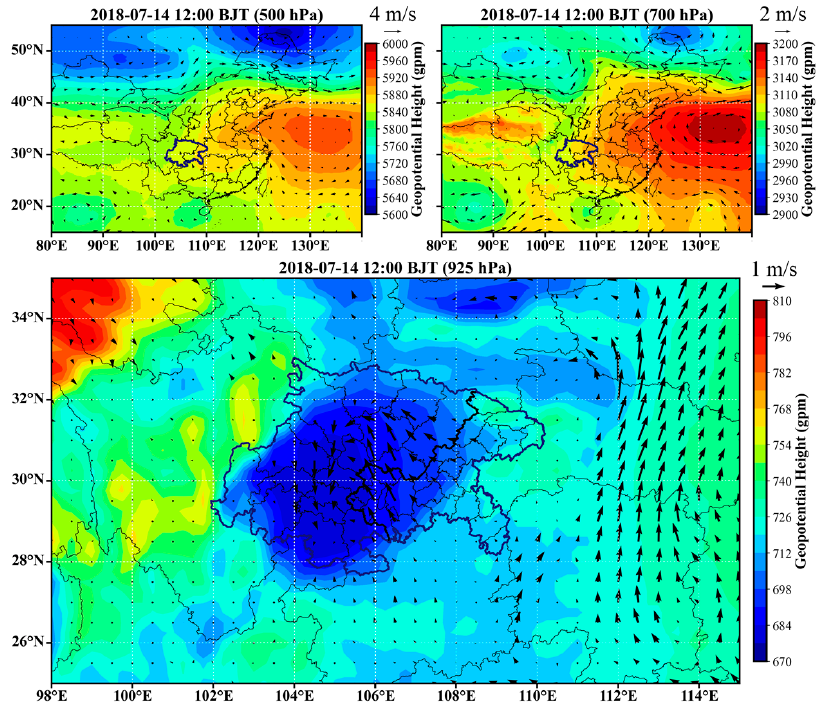
Figure 8. Typical circulation features in summer. The arrows represent horizontal wind vectors.